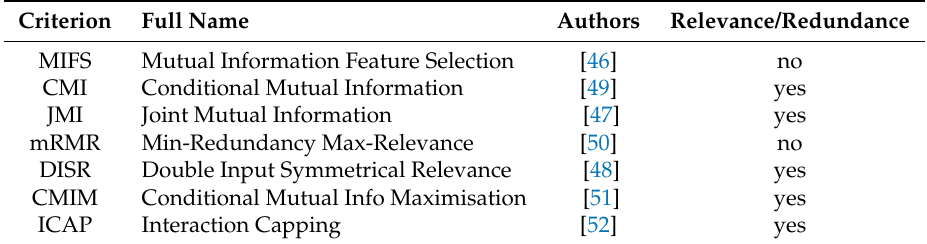
Table 1. Information-based criteria used in the